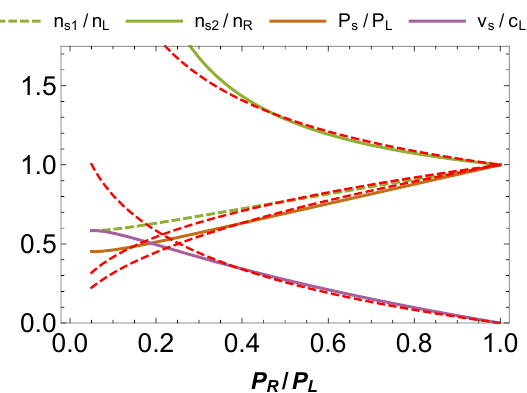
Figure 8. NESS variables for a Lifshitz (cid:13)uid at d = 3, z = 1 and n L =n R = 2 as a function of P R =P L . For comparison, the corresponding variables for a relativistic (cid:13)uid considered in [8, 9] are shown by the red dashed curves. The solutions are well matched as P R =P L !